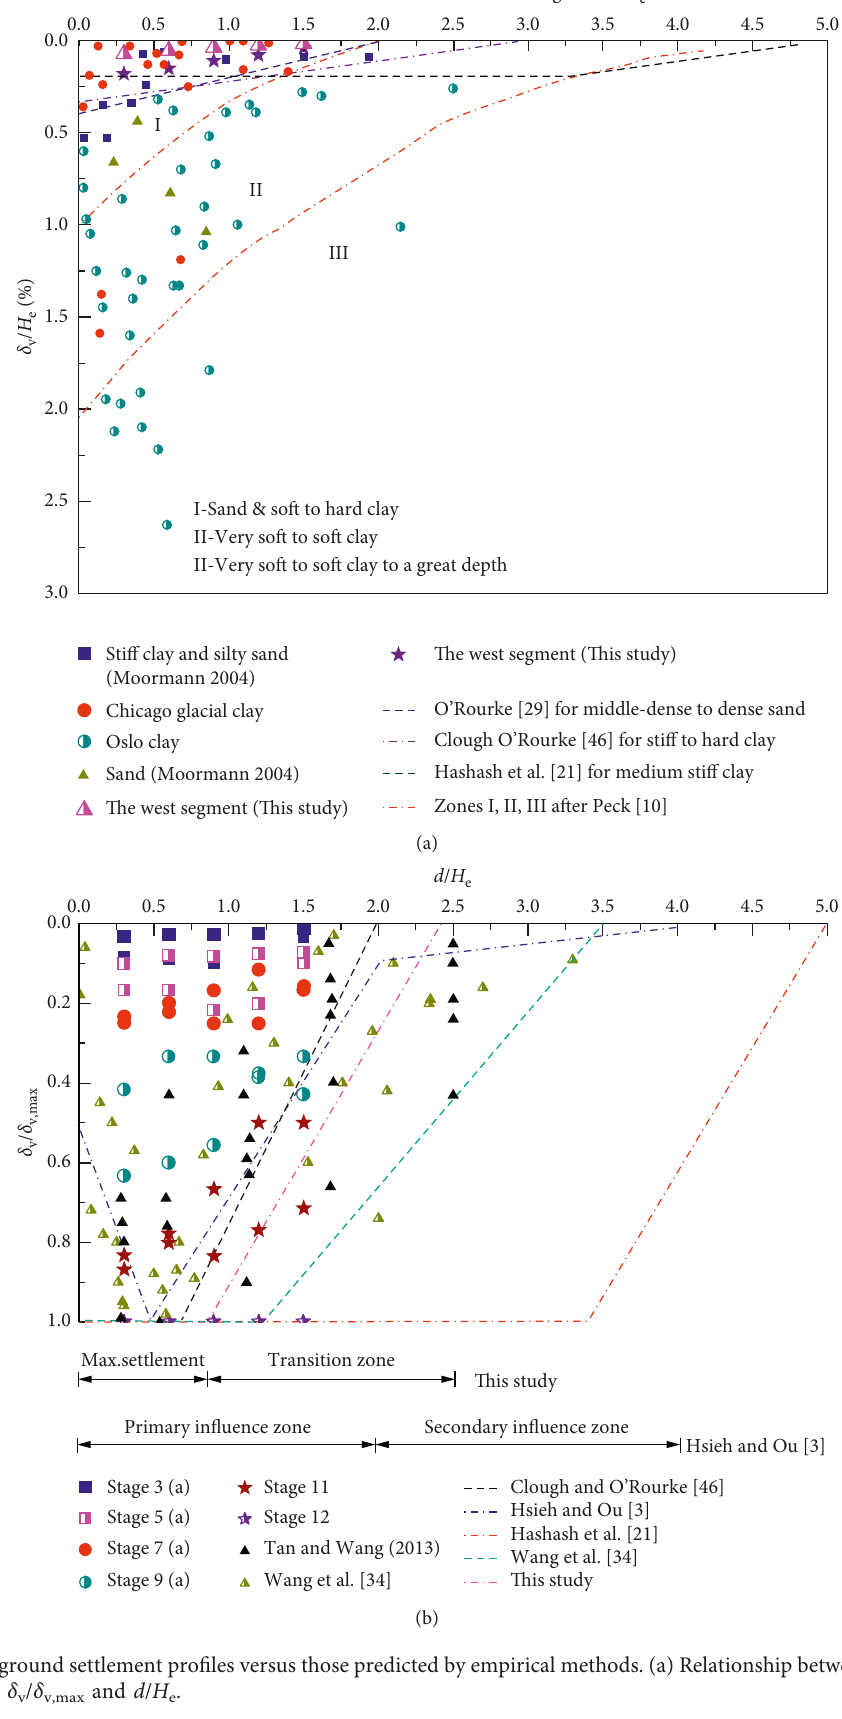
v / H e and d / H e . (b)